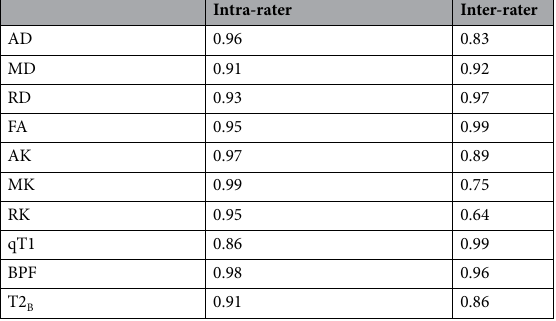
Table 3. Intraclass correlation coefficient (ICC) results of the standard DTI metrics axial/radial/mean diffusivity (AD/RD/MD) and fractional anisotropy (FA), DKI metrics axial/radial/mean kurtosis (AK/RK/